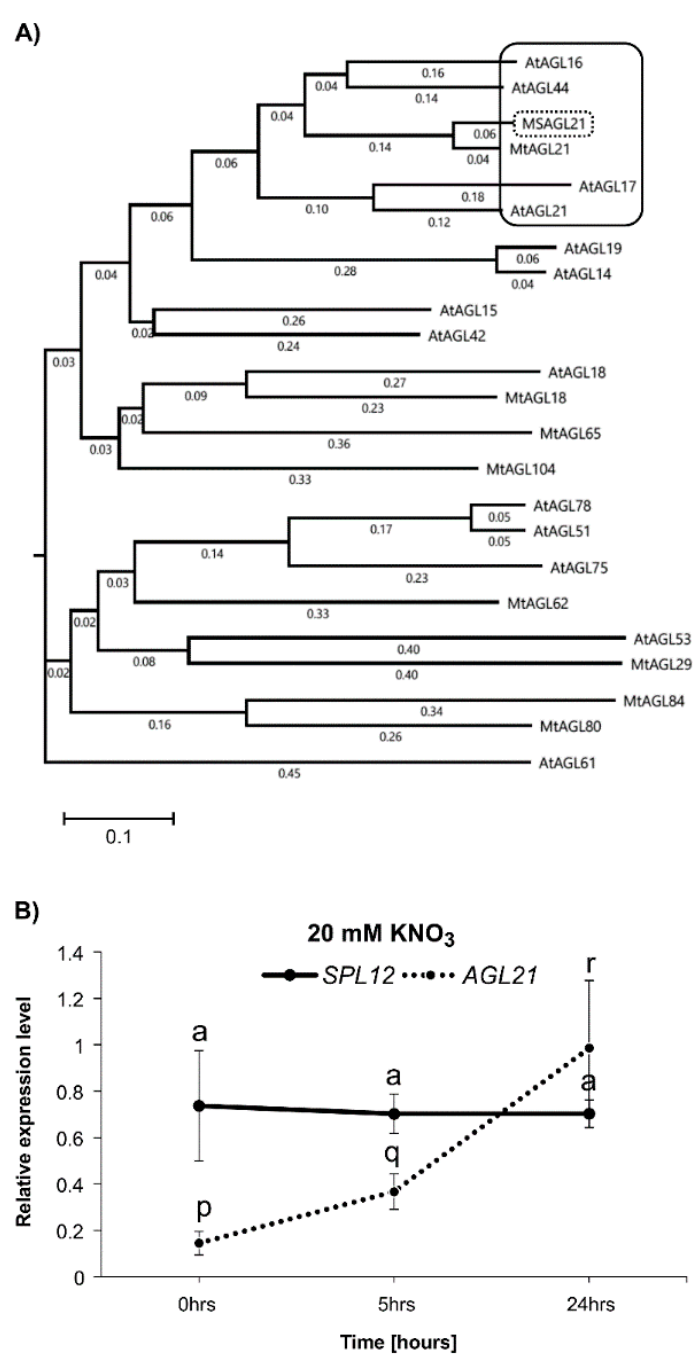
Figure 2. Phylogenetic tree of M. truncatula and Arabidopsis MADS-box proteins. ( A ) Phylogenetic tree based on protein sequences between AGL21 and some other MADS-box transcription factors of M. truncatula and Arabidopsis. Black frame: ANR1 clade; Black-dashed frame: AGL21 in alfalfa. ( B ) Relative gene transcript levels of SPL12 and AGL21 were analyzed in WT at 0, 5, and 24 h after 20 mM nitrate treatment. Statistical groupings across different time points were determined separately for SPL12 and AGL21 transcript abundance using one-way ANOVA with the Tukey HSD post hoc test. Significant difference in post hoc Tukey multiple comparisons test is indicated with different letters (“a” for SPL12 expression level and “p, q, and r” for AGL21 expression level) Error bar indicates standard